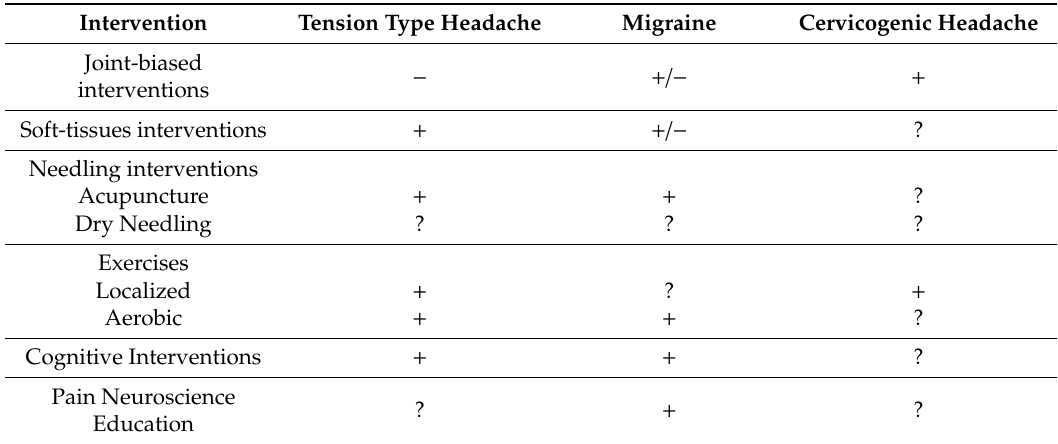
Table 1. E ff ects of non-pharmacological interventions in tension-type headache (TTH), migraine and cervicogenic headache